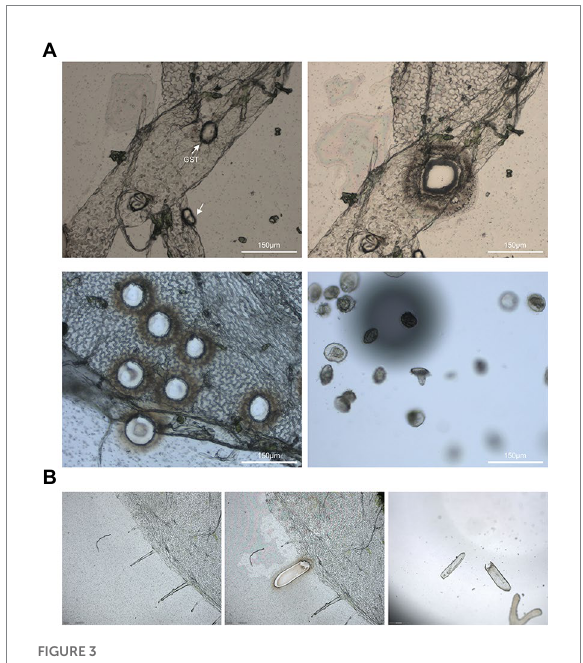
FIGURE 3 (A) The glandular secretory trichomes of A. annua was selected using the PALM® Laser-Microbeam system. The optimal value for cut energy was 54 and the best value for laser pressure catapult energy was 60. The best values were 70 for cut focus, and the optimal value for LPC focus was 46. (B) Laser capture microdissection of glandular secretory trichomes of N. benthamiana